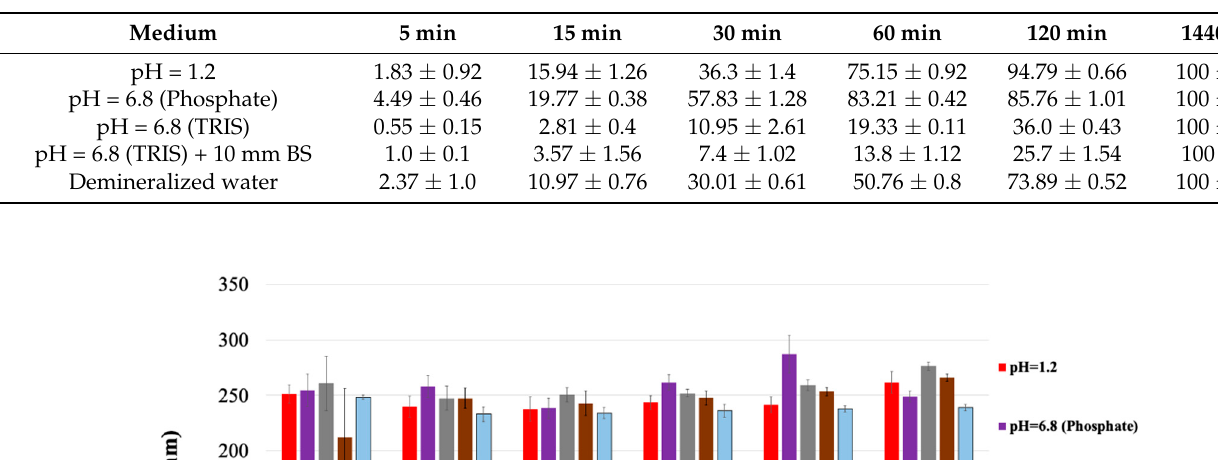
Table 2. The percentages of derived count rates (DCR t /DCR 1440min × 100) of various dissolution media (carrier = PVA; n = 3; mean ± SD).